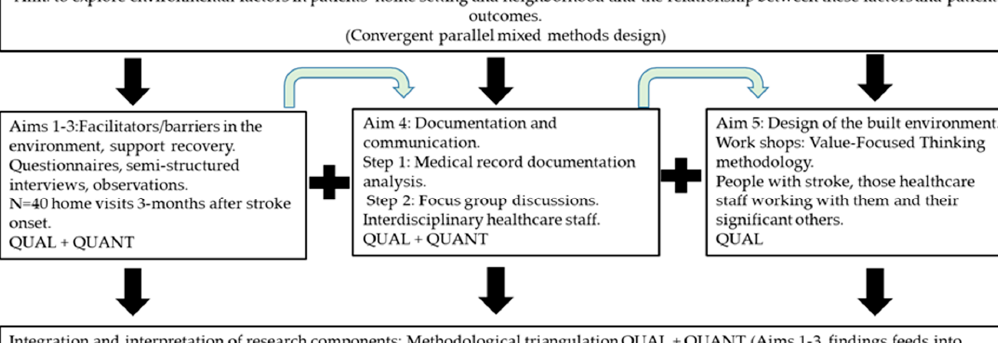
Figure 2. Methods flow chart.